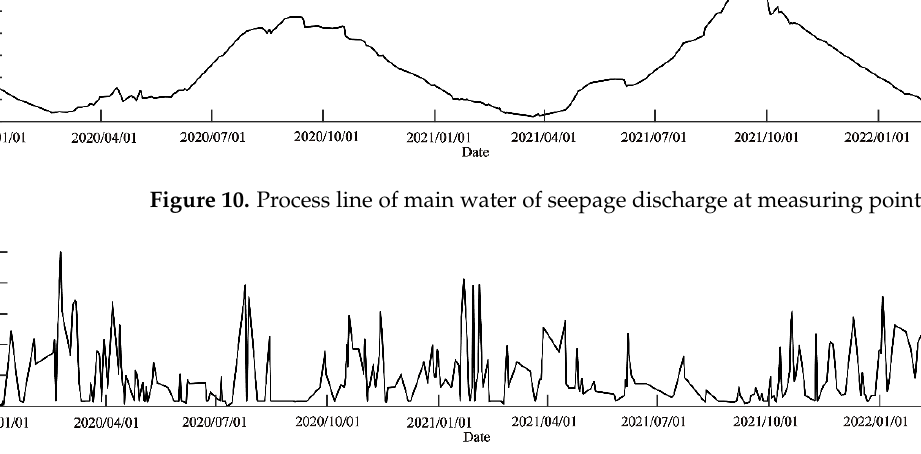
Figure 11. Process line of foreign water of seepage discharge at measuring point WE01YXD.